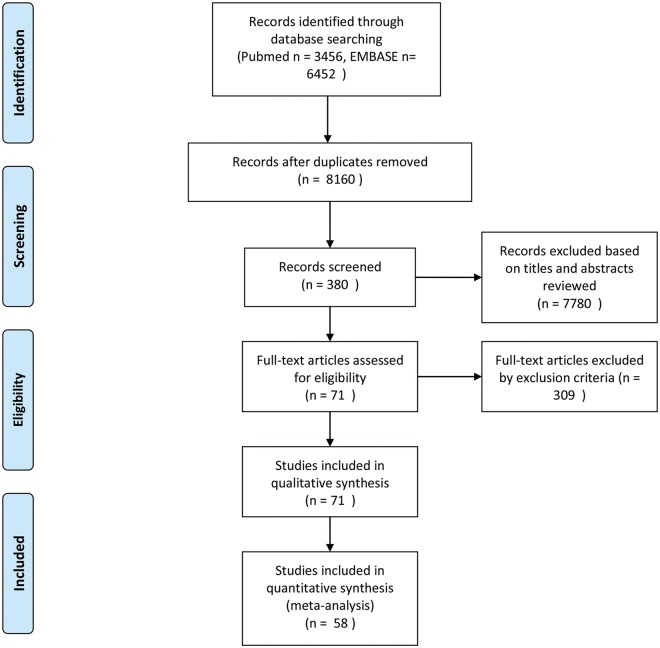
Flow chart of study design.